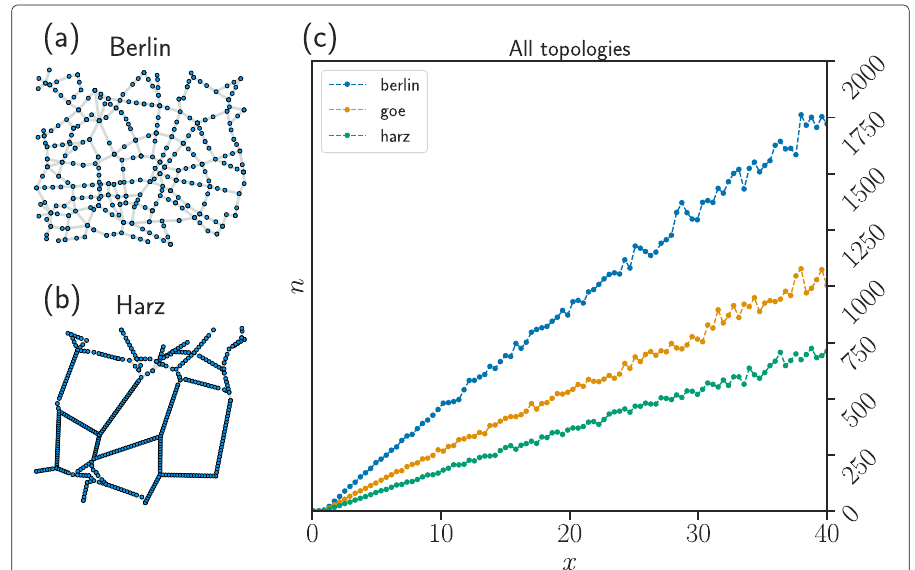
Fig. 5 Ride-sharing on a variety of street networks. The length of the planned route n grows linearly with the normalized request rate x , with a slope dependant on the topology of the network. a Example street network extracted from Berlin, b Example street network extracted from Harz, c n vs. x for networks from Berlin, Göttingen and